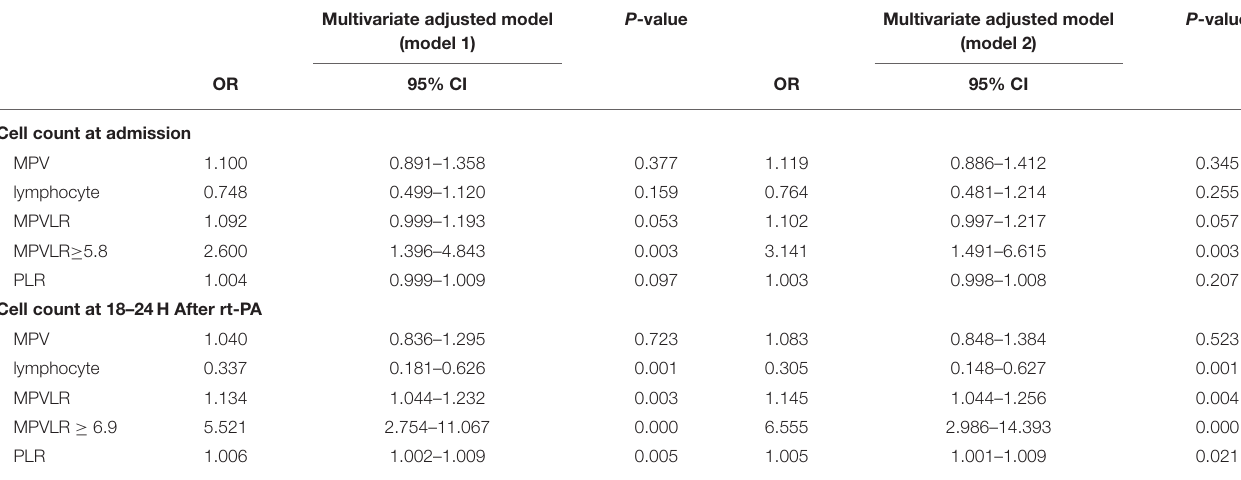
TABLE 5 | Multivariate logistic regression analysis of the associations between MPV, lymphocyte, MPVLR, and poor